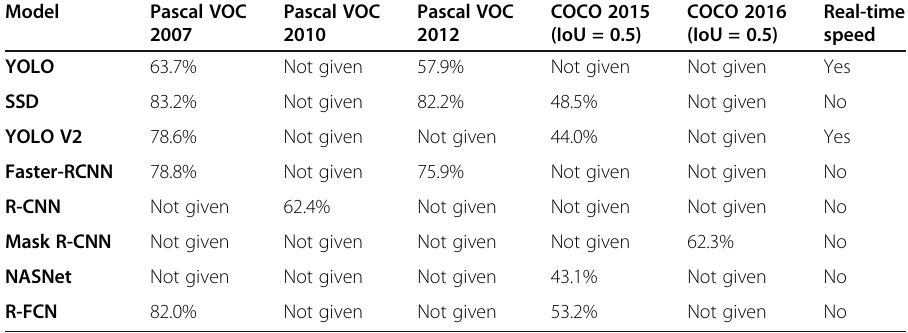
Table 3 The value of mAP on the 2007, 2010, 2012 VOC dataset, and 2015, 2016 COCO datasets